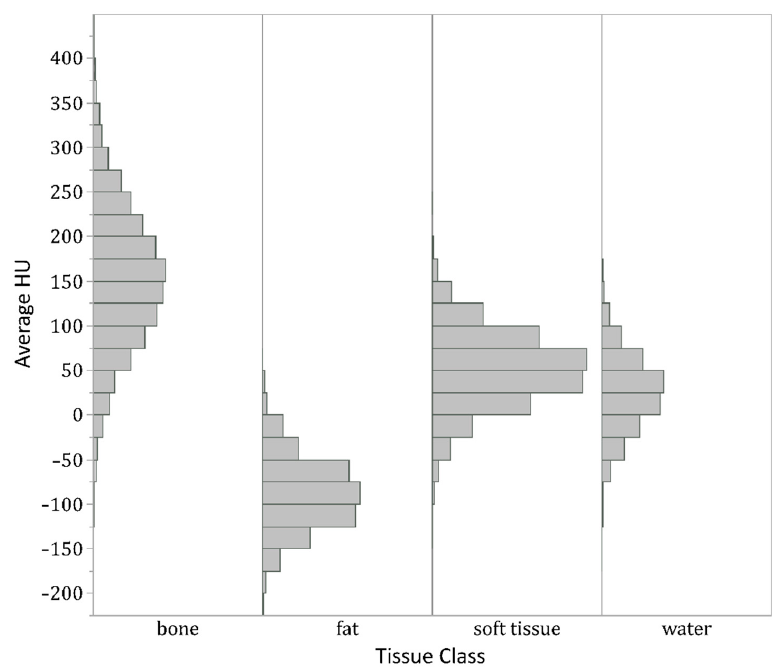
Figure 4. Histogram of average center Hounsfield units (HU) of all 3 × 3 × 3 × 2 patches generated from the labeled ROIs. Although center pixels in patches from bone ROIs, not unexpectedly, show higher HUs on average than water and soft tissue patches, and fat patches show lower HUs, the tissue classes show substantial overlap in HUs. In particular, the histograms for soft tissue and water are nearly superimposable. Therefore, no HU thresholding could separate all four classes with high accuracy.